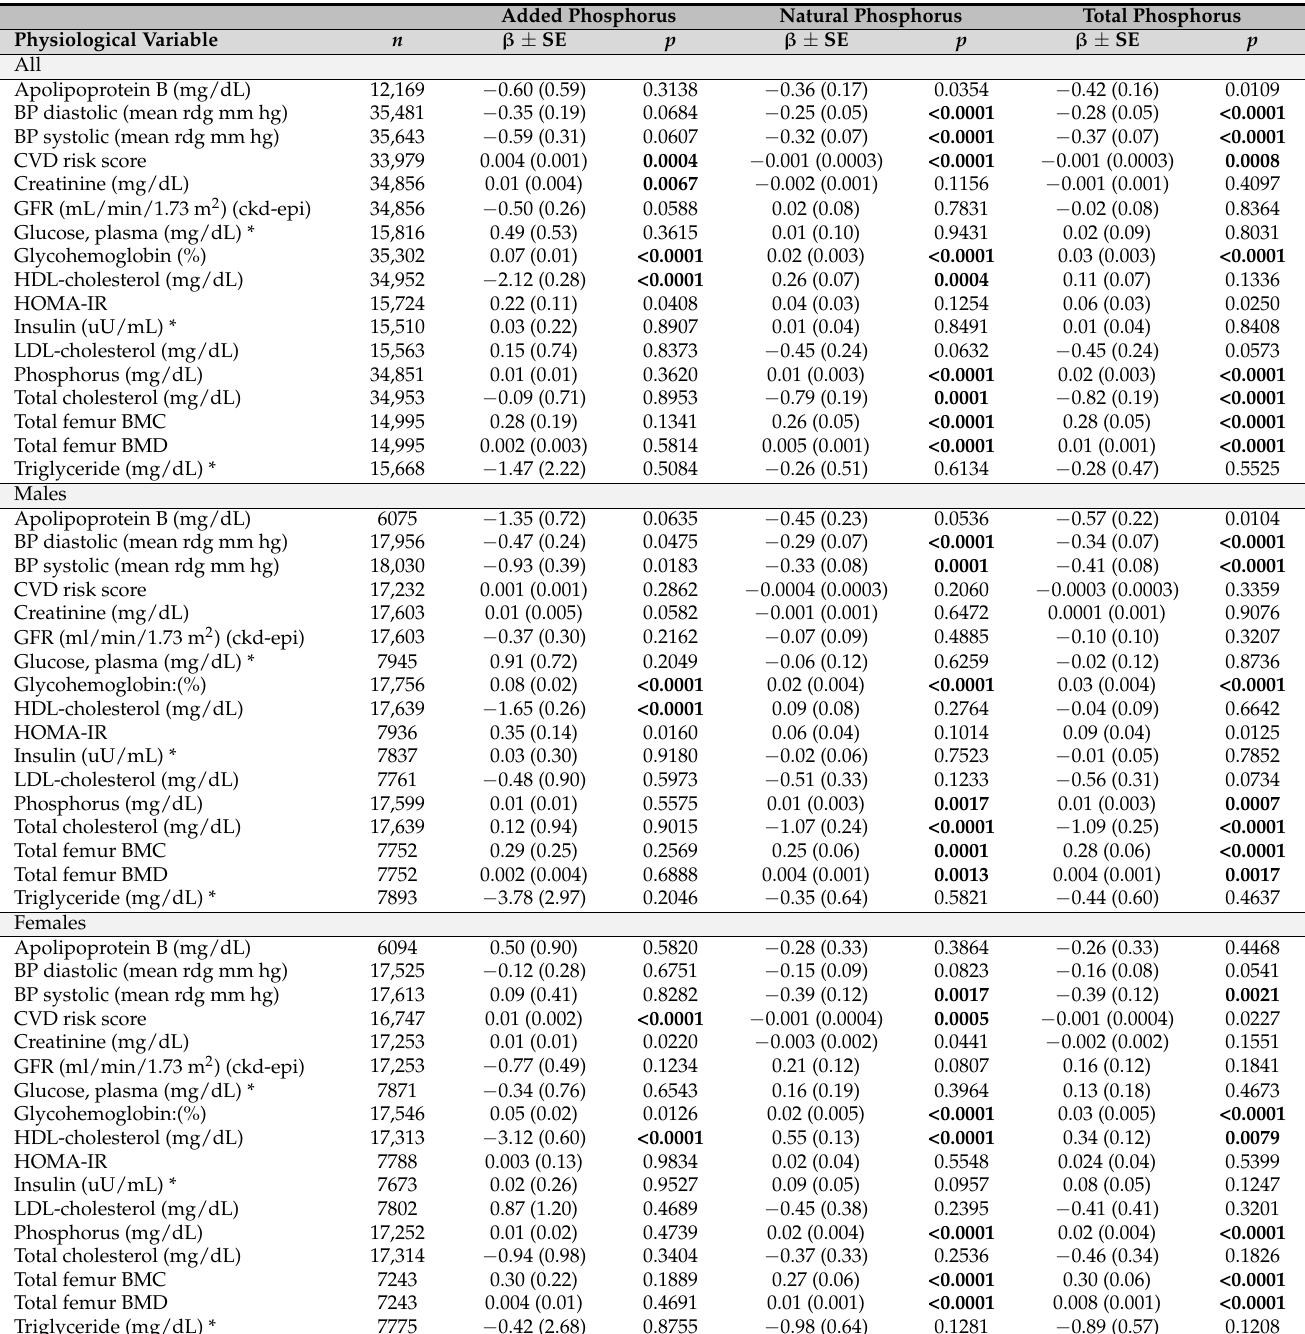
Table 1. Association of total, added, and natural phosphorus individual usual intake 1,2 (100